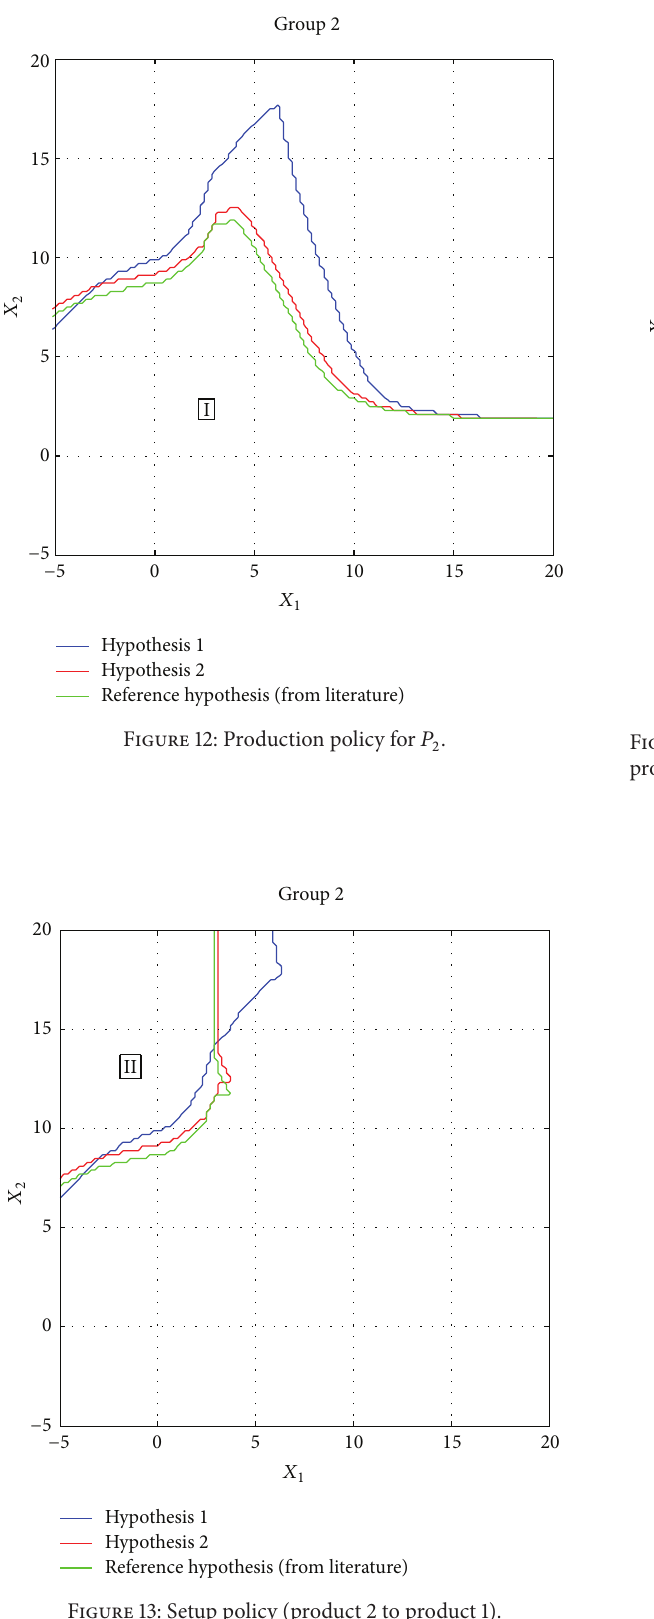
Figure 15: Production policy for 𝑃 1